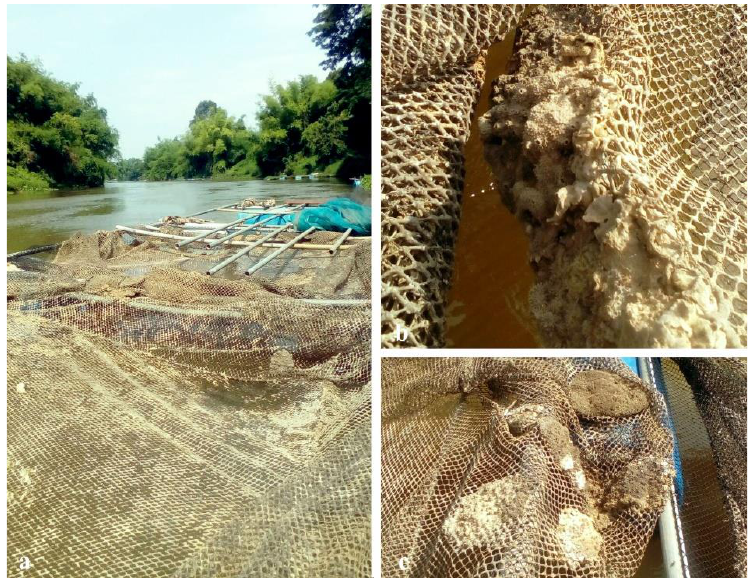
Figure 10. Fish cage maintenance after harvesting in the Pong River. ( a ) Fisherman with dried nets. ( b , c ) Freshwater sponges encrusting on farm nets. ( b , c ) Freshwater sponges encrusting on farm